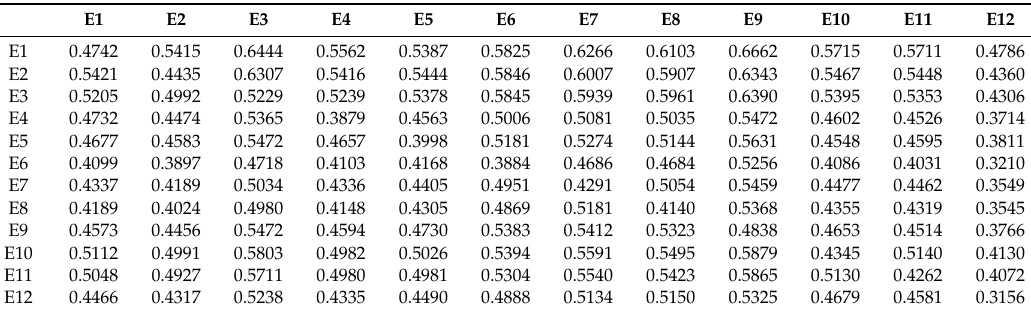
Table 11. Total cause and e ff ect matrix ( T ).